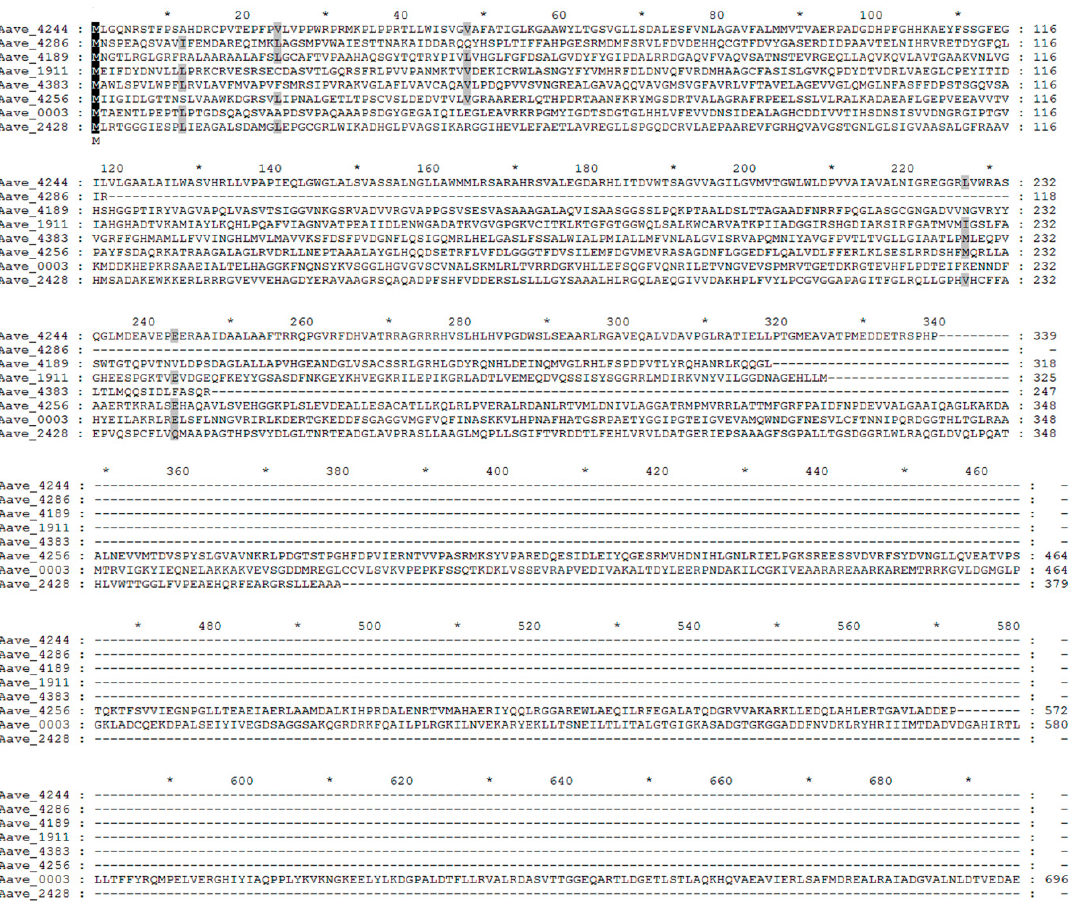
Figure 3. Traditional exploratory visual analysis of multiple sequence alignment. A depiction of the multiple sequence alignment of the predicted proteins of the eight virulence-related genes. *, addition of position by 10 amino acids; black background, the sequences were identical; gray background, the sequences were similar.